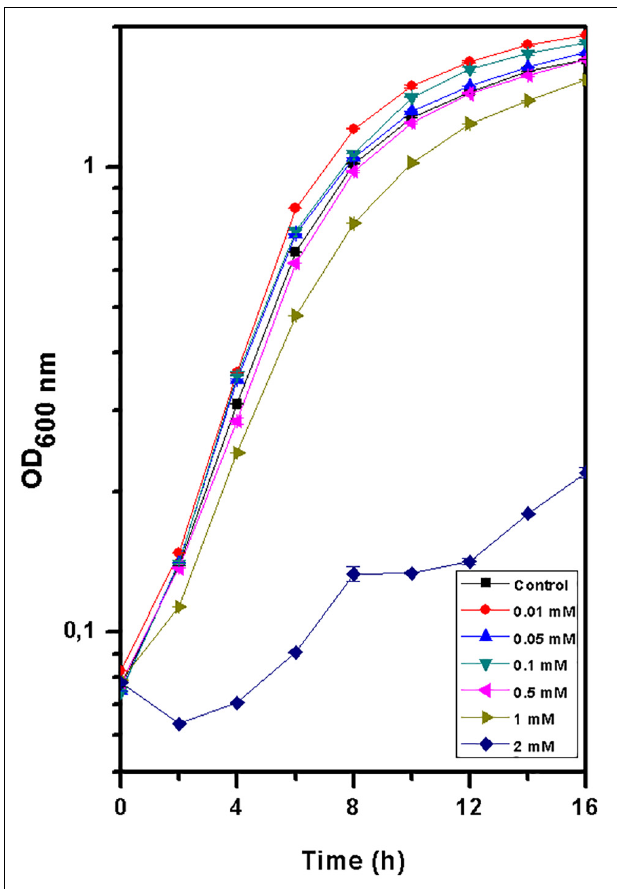
FIGURE 1 | Growth curve of Thermus scotoductus SA-01 in TYG media over a 16 h period. Symbols indicate the mean value of OD 600 nm samples. Standard deviations are included but are negligible.